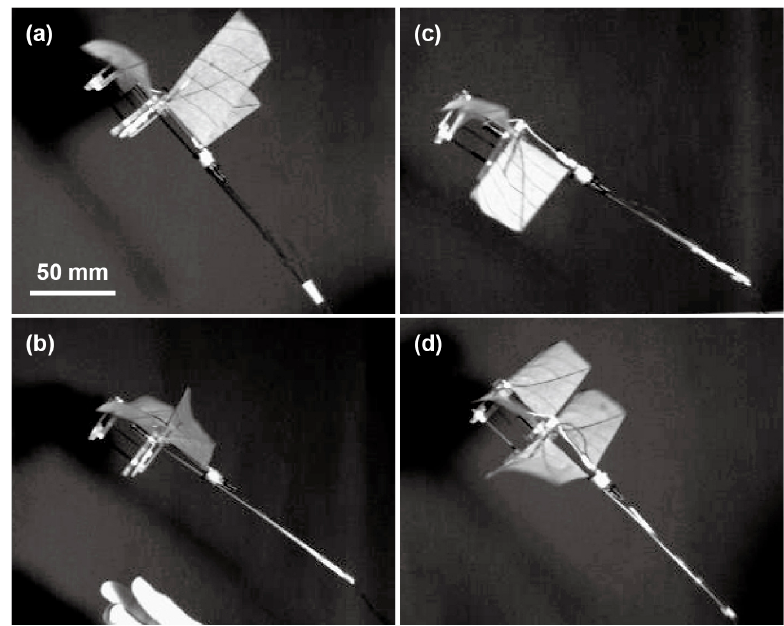
Figure 10. Zoom-in images of the flying ornithopter for the four modes. The captured images correspond to the forewing downstroke. The phase angles correspond to those in Figure 9.